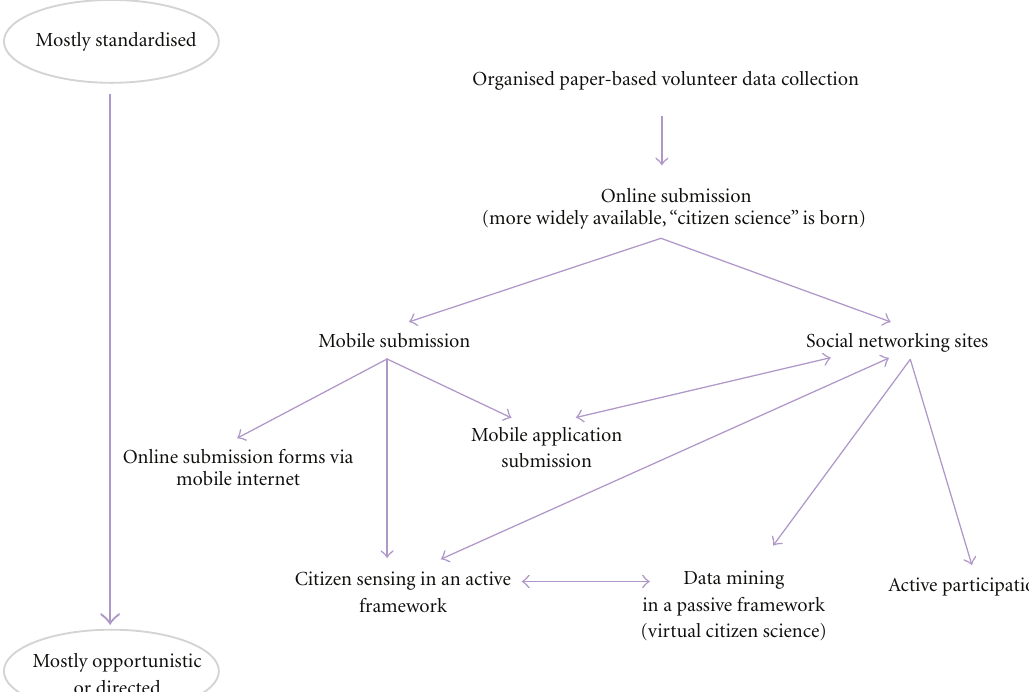
Figure 1: A brief diagram of citizen science, the diagram shows the proliferation in citizen science as new technologies have become available.